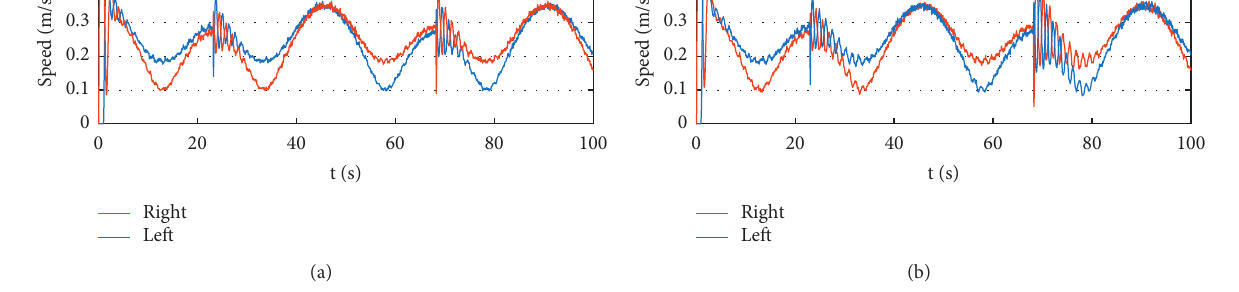
Figure 11: Speeds comparison. (a) FOPID and (b) PID.